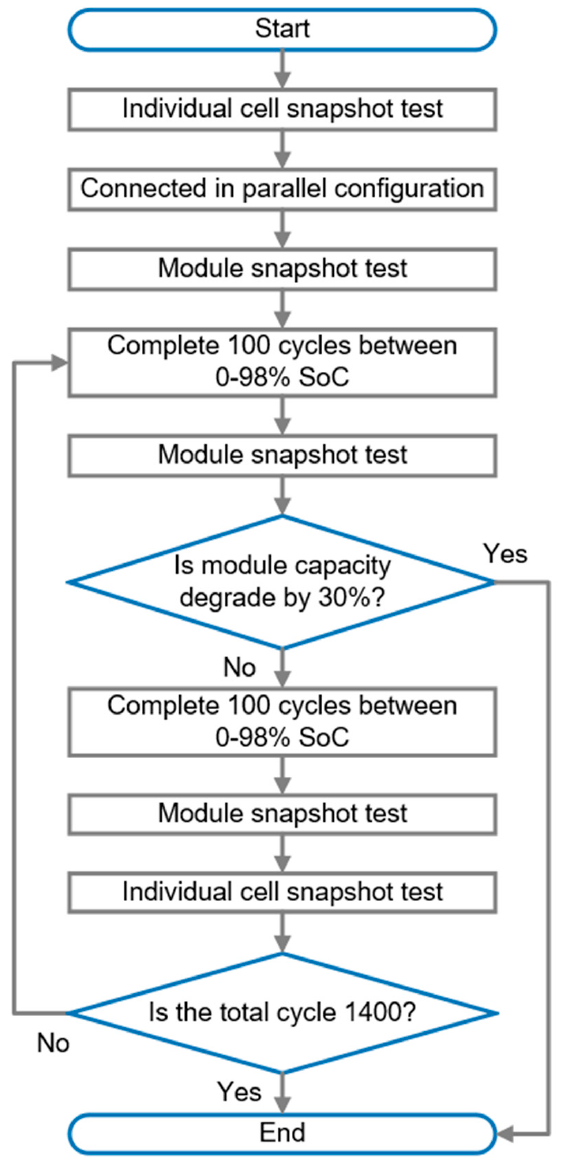
Figure 2. The sequence of snapshot test of individual cells, 4P module and degradation cycles.